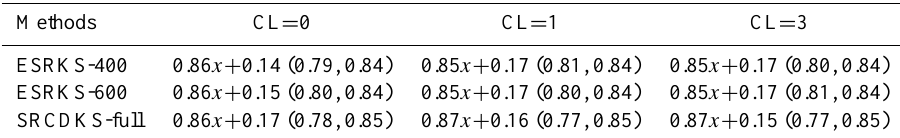
Table 3. Inversion results using different correlation lengths (CL) with the lag length equals to 7. All statistics are tested for statistical significance with p < 0 . 001. The first value in the brackets is the root mean square error of the inversion; the second value is the R 2 value of the linear regression. The regressions are the posterior fluxes against the true fluxes. Interval constraints are applied using the variable transform method described in the text. The SRCDKS is implemented with the full set of sigma points determined by the error covariance matrix of the state